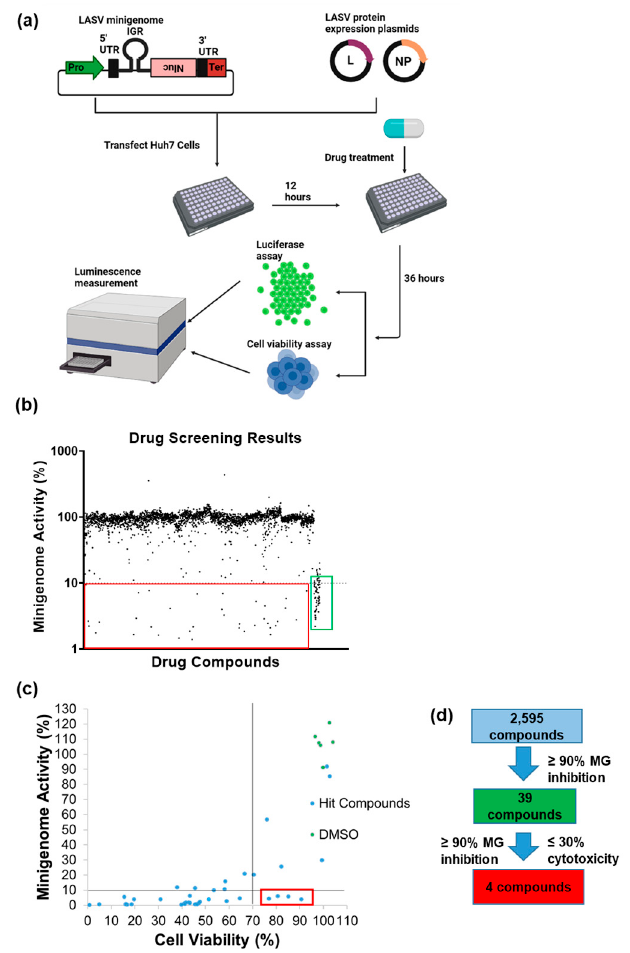
Figure 2. HTS for inhibitors of LASV MG activity using an FDA-approved drug library. ( a ) Schematic protocol of the compound screen. ( b ) HTS of a library of 2595 compounds for inhibitors of LASV MG activity. The percentile inhibition by each compound is represented by a black dot. Hit compounds (at a concentration of 5 µ M) and positive controls (100 µ M ribavirin and 5 µ M MPA) are bordered by red and green rectangles, respectively. All assays were performed in duplicate simultaneously. The results were normalized to DMSO-treated wells. ( c ) Results of rescreening and cytotoxicity analyses of the hit compounds in ( b ). MG activity inhibition ≥ 90% and cell viability ≥ 70% were the criteria for the compounds selected for further analyses (bordered by a red rectangle). The results were normalized to DMSO-treated wells. ( d ) Schematic description of how the hit compounds were selected after the initial HTS and then for further